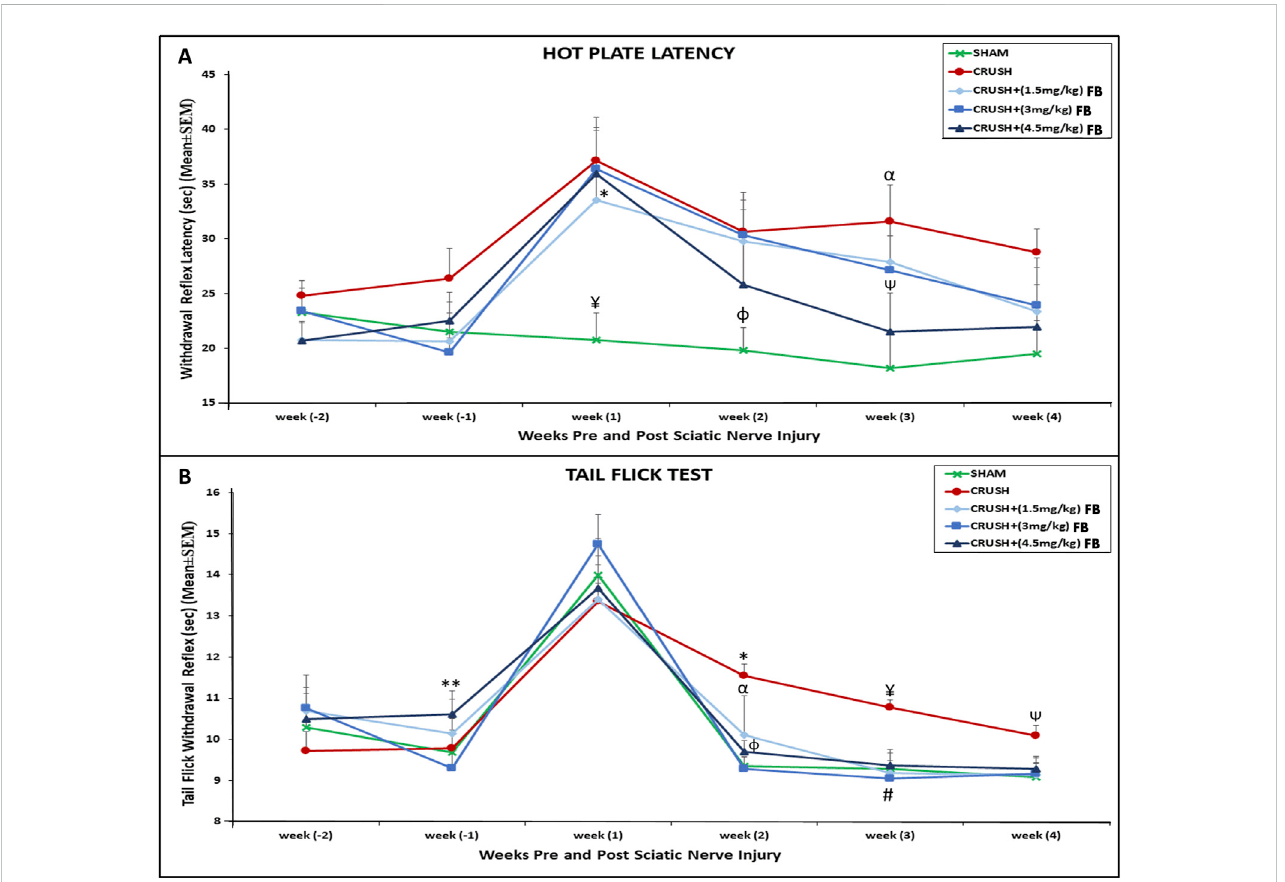
FIGURE 2 (A) Time courseof hot plate latency. Nerve crush injury producedasevere nociception de fi cit inthe Crush group. ¥ indicates p < 0.01, SHAM vs. CRUSH, CRUSH+(3 mg/kg) FB and CRUSH+(4.5 mg/kg) FB; * indicates p < 0.05, CRUSH+(1.5 mg/kg) FB vs. SHAM; φ indicates p < 0.05, SHAM vs. CRUSH and CRUSH+(3 mg/kg) FB; α indicates p < 0.01, CRUSH vs. SHAM; Ѱ indicates p < 0.05, CRUSH+(4.5 mg/kg) FB vs. CRUSH. (B) Time course of tail fl ick withdrawal latency. The treated group showed signi fi cant nociceptive recovery compared with the CRUSH group. * indicates p < 0.01, CRUSH vs. SHAM and CRUSH+(3 mg/kg) FB; α indicates p < 0.05, CRUSH+(1.5 mg/kg) FB vs. CRUSH; φ indicates p < 0.05, CRUSH+(4.5 mg/kg) FB vs. CRUSH; ¥ indicates p < 0.01, CRUSH vs. SHAM, CRUSH+(1.5 mg/kg) FB and CRUSH+(4.5 mg/kg) FB; # indicates p < 0.001, CRUSH+(3 mg/kg) FB vs. CRUSH; Ѱ indicates p < 0.05, CRUSH vs. SHAM and CRUSH+(1.5 mg/kg) FB; ** indicates p < 0.05, CRUSH+(4.5 mg/kg) FB vs. CRUSH+(1.5 mg/kg)